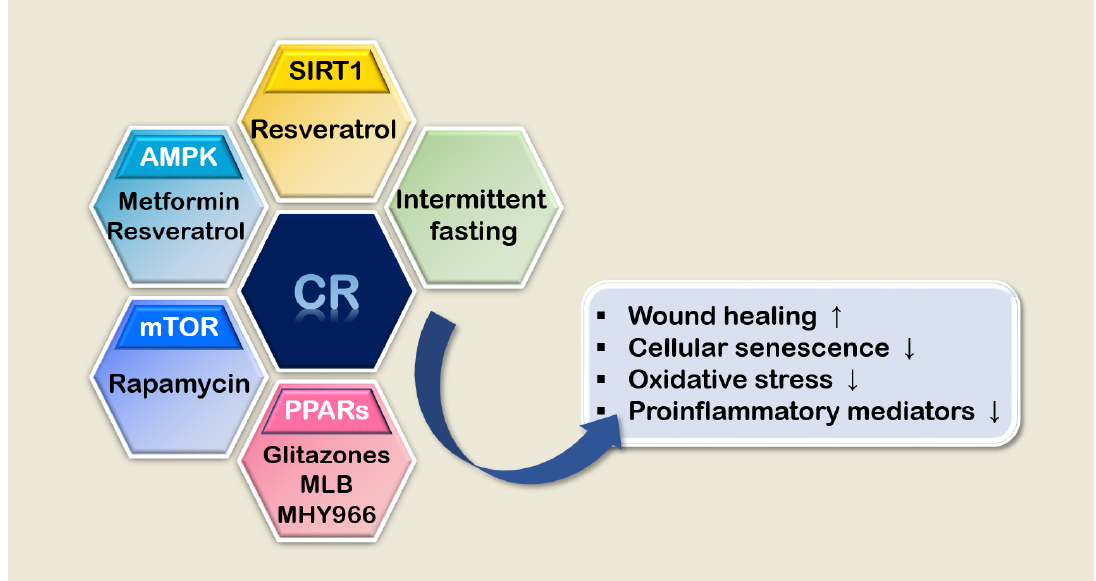
Figure 1. Summary of CR mimetics and their effects on skin aging. AMPK, AMP-activated protein kinase; CR, calorie restriction; MLB, magnesium lithospermate B; mTOR, the mammalian target of rapamycin; SIRT1, the mammalian homolog of SIR2; PPAR, peroxisome proliferator-activated receptors.